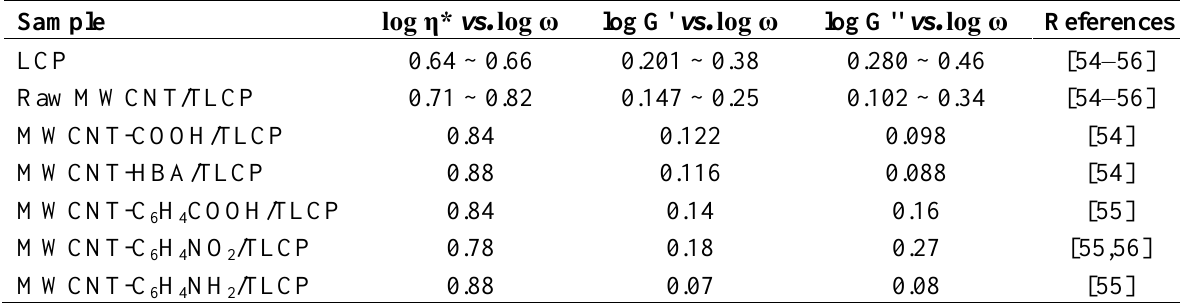
Table 2. Power law indices for complex viscosity (η*), storage modulus (G'), and loss modulus (G'') with respect to angular frequency (ω) where the amount of MWCNT was fixed at 1